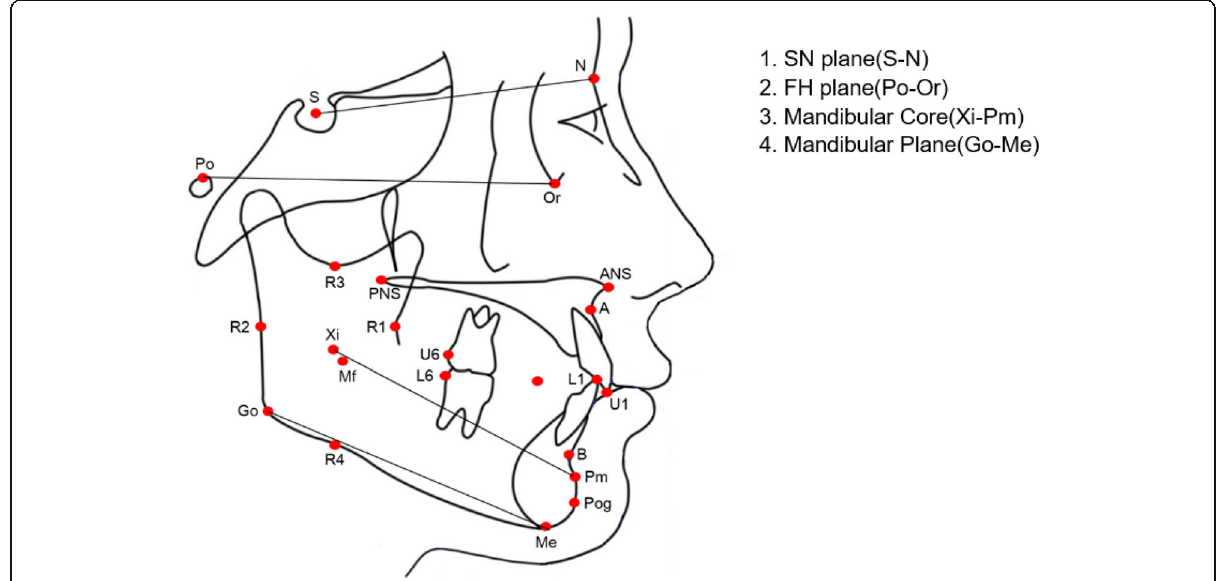
Fig. 2 Three occlusal planes used for the cephalometric